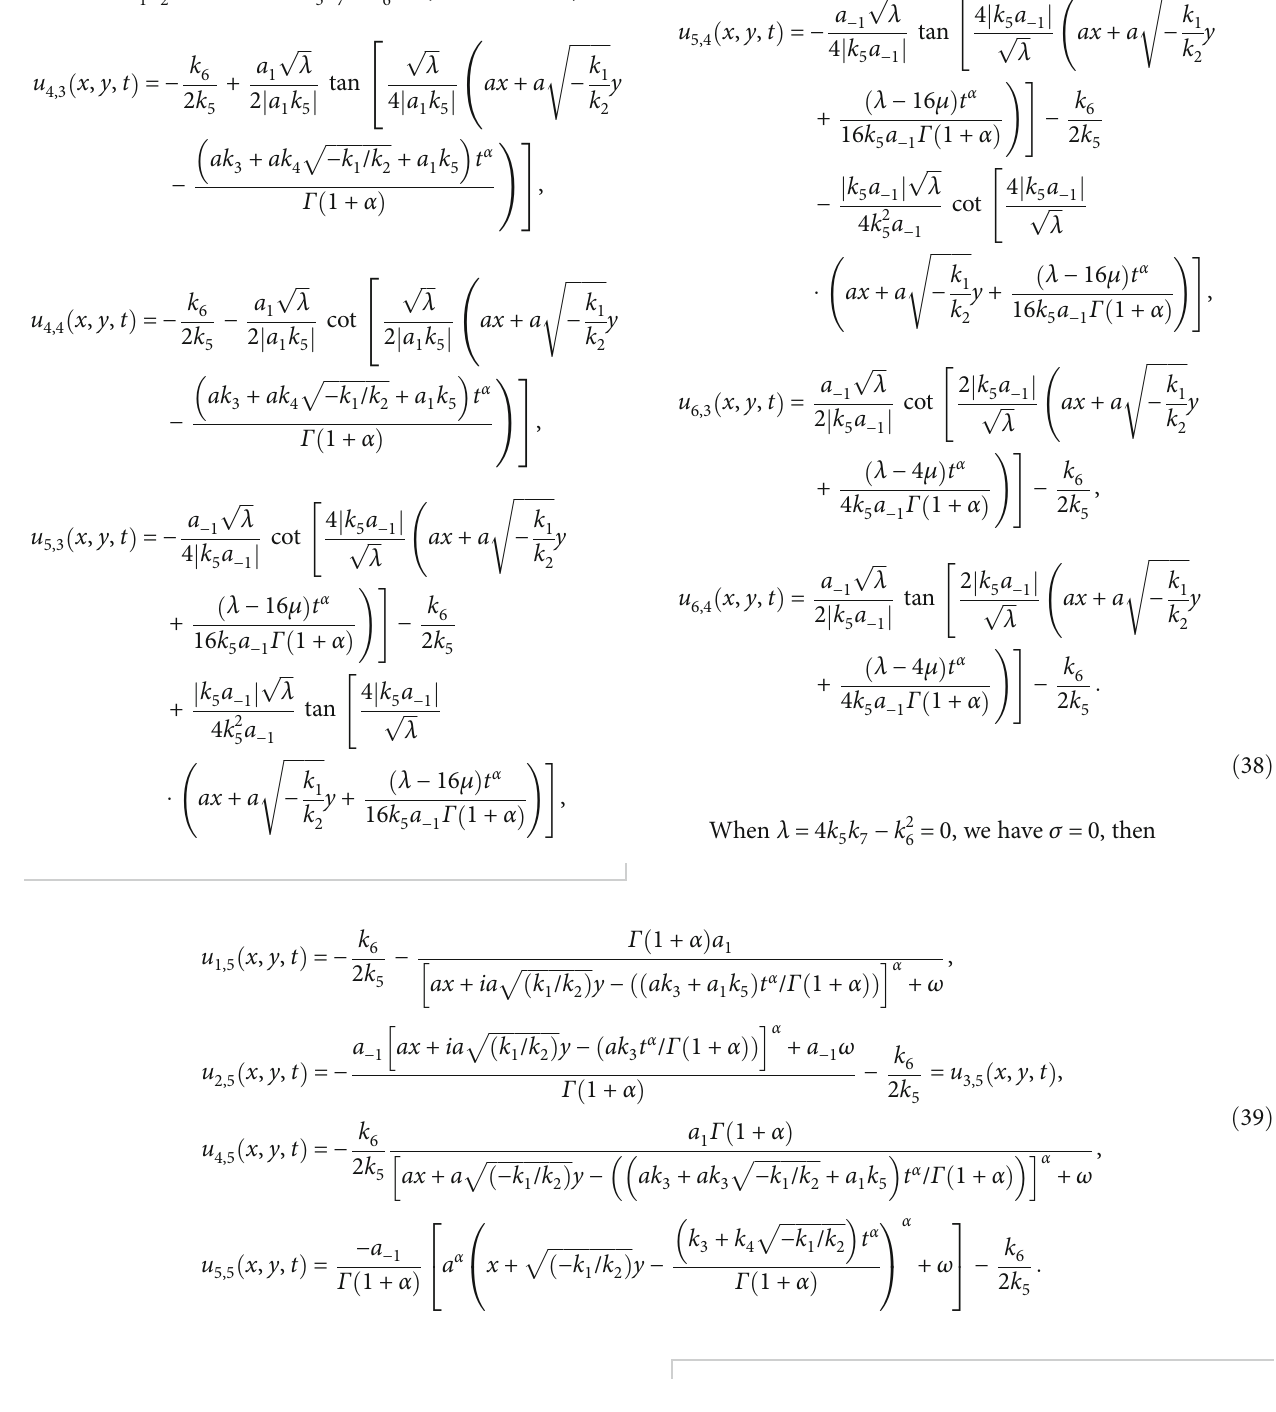
ffiffiffiffiffiffiffiffiffiffiffiffiffiffiffiffiffi − k / k ð 1 2